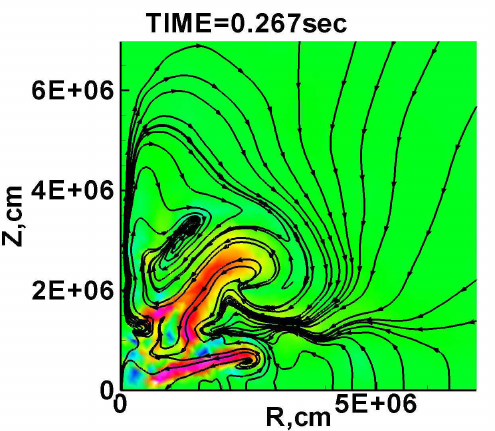
Figure 8: Developed MDRI due to convection and MRI/Tayler instability at t = 267ms for the case H 0 = 10 9 G , E rot 0 /E grav 0 = 1% (contour plot - the toroidal magnetic field, arrow lines - force lines of the poloidal magnetic